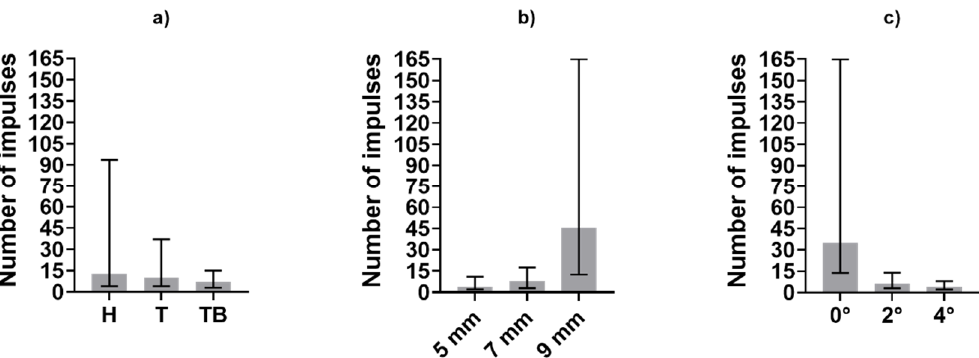
Figure 8. Medians and variability interval of impulses required for removal computed in subgroups divided according to ( a ) luting agent, ( b ) abutment height and ( c ) abutment taper angle.